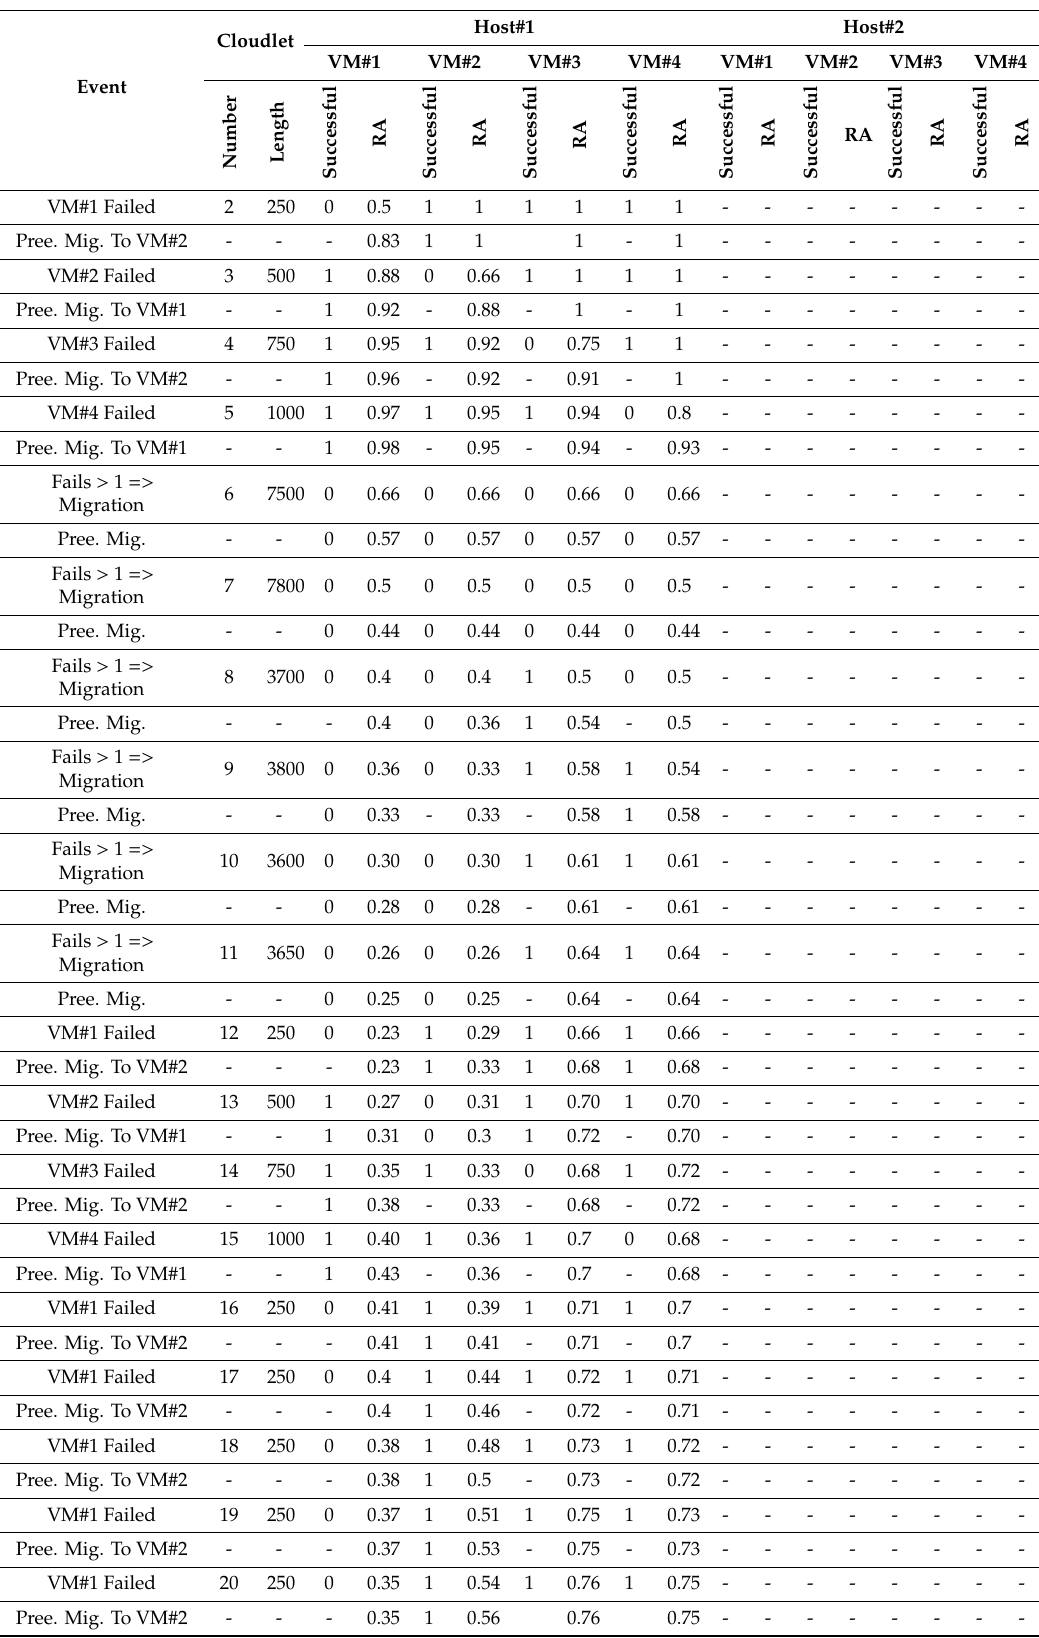
Table 4. Results of Simulating VFT in